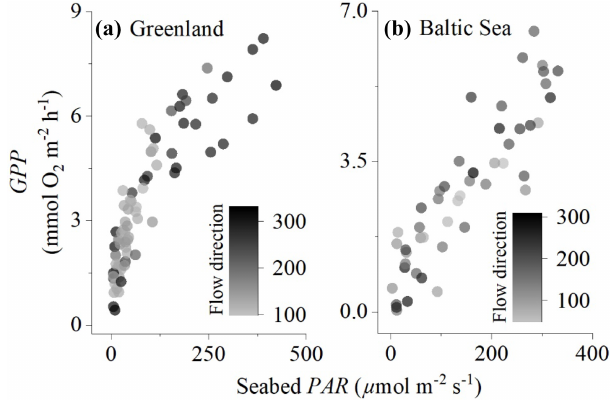
Figure 2. Comparison of eddy covariance fluxes for (a) the sedi- mentary embayment in Greenland and (b) the rocky mussel reef in the Baltic Sea. Flow direction (instrument degrees) illustrates that different parts of the sea floor were included in the measurements, but this did not substantially impact the magnitude of the